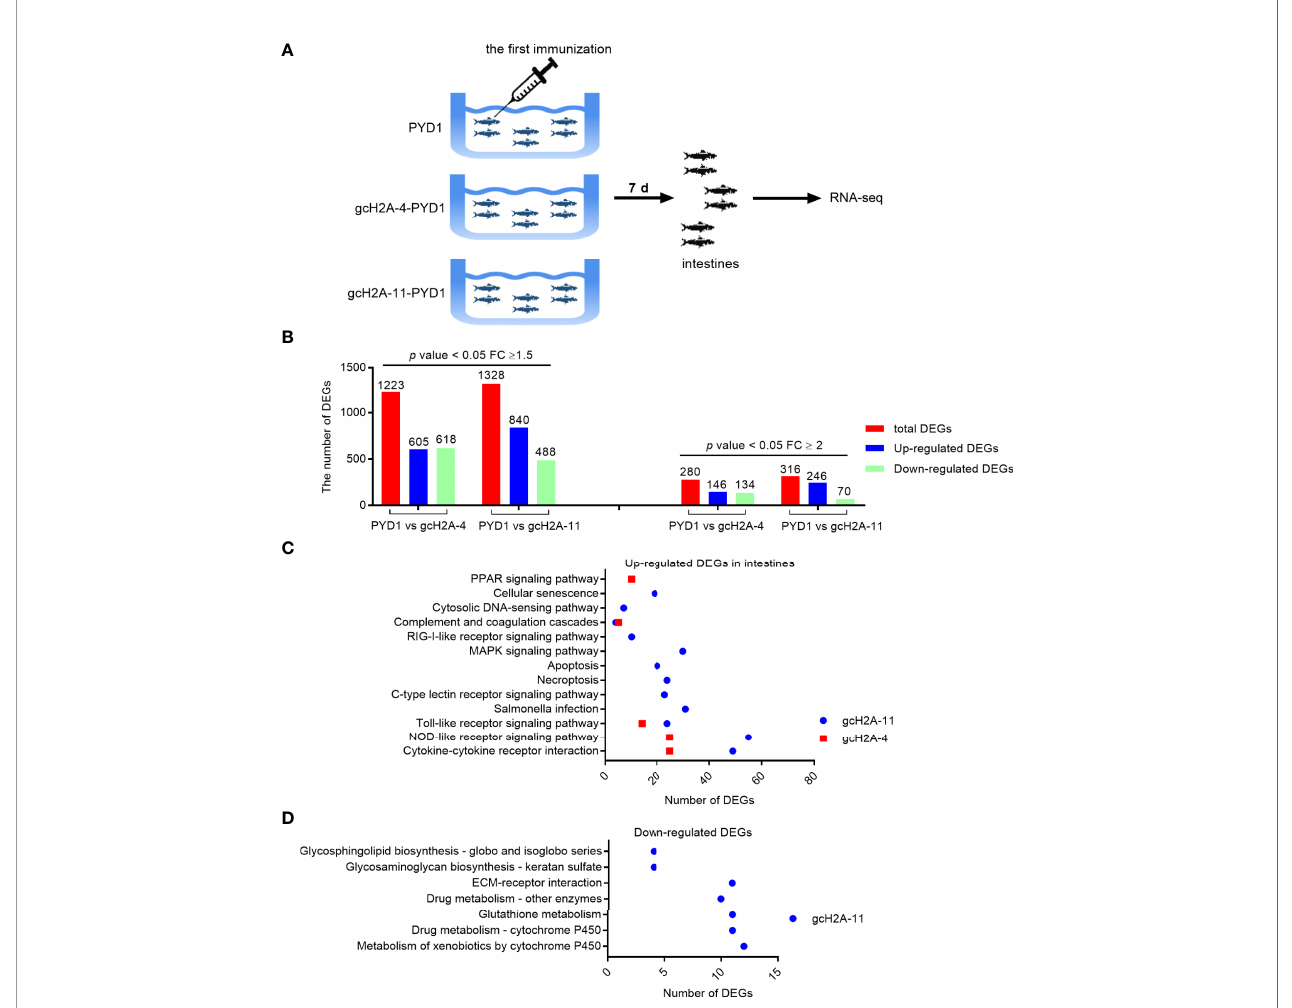
FIGURE 4 | Differentially expressed genes and signi fi cantly enriched KEGG pathways in grass carp regulated by the engineered S. cerevisiae expressing gcH2A-4 and gcH2A-11. (A) The schematic diagram for the immunized grass carp used for illumina deep sequencing. (B) The number of DEGs regulated by the engineered S. cerevisiae expressing gcH2A-4 and gcH2A-11. (C) The signi fi cantly enriched KEGG pathways for up-regulated DEGs in intestines regulated by the engineered S. cerevisiae expressing gcH2A-4 and gcH2A-11. (D) The signi fi cantly enriched KEGG pathways for down-regulated DEGs in intestines regulated by the engineered S. cerevisiae expressing gcH2A-4 and